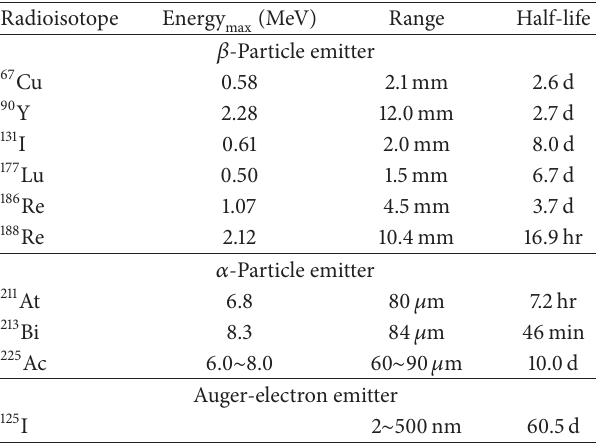
Table 1: Radioisotopes used in